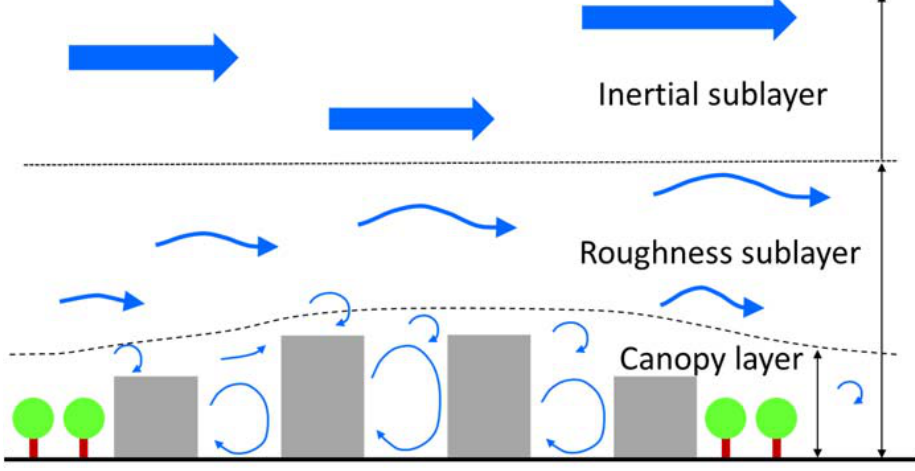
Figure 5. Schematic of TBL flows over buildings. Adopted from Britter and Hanna [27].